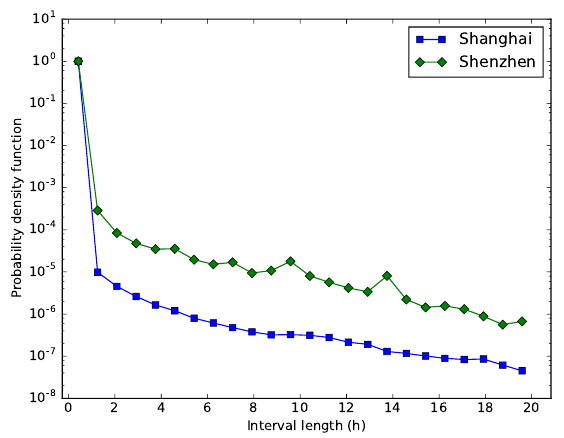
Figure 14. The Distribution of Interval Length of Two Adjoined